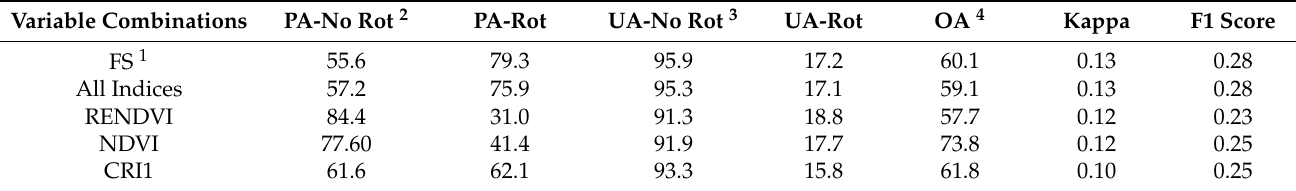
Table 8. Selected model results from the Nordskogen study